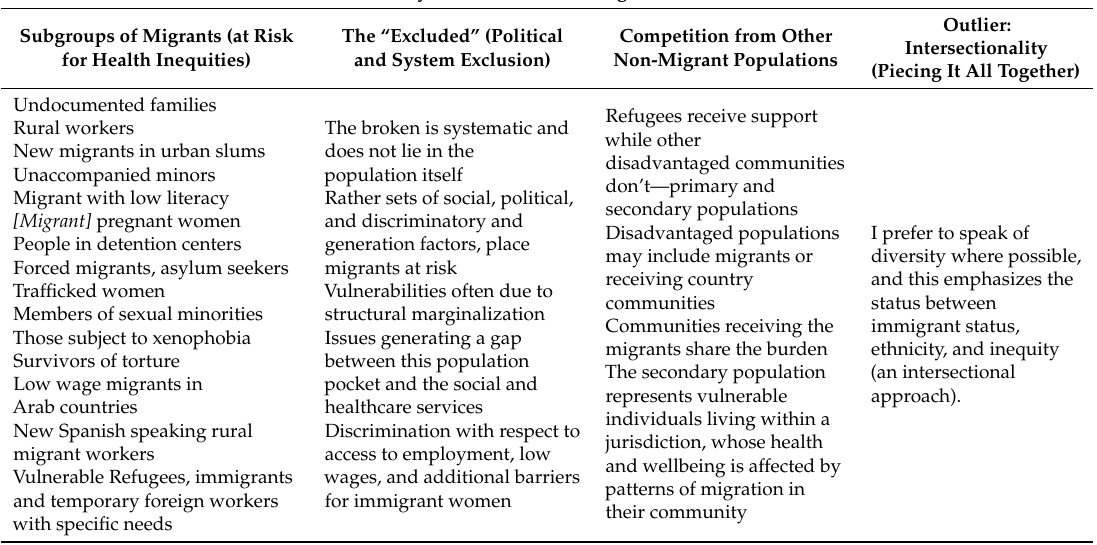
Table A1. Describing Disadvantage Persons Affected by Migration.